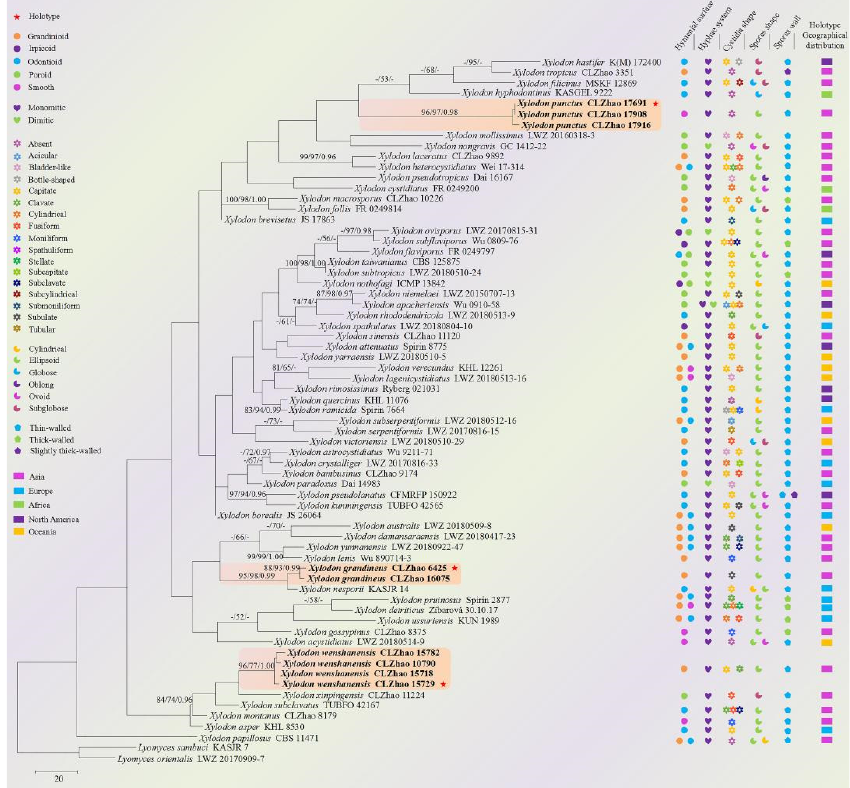
Figure 2. Maximum parsimony strict consensus tree illustrating the phylogeny of three new species in Xylodon based on ITS sequences. Branches are labeled with a maximum likelihood bootstrap value > 70%, a parsimony bootstrap value > 50%, and Bayesian posterior probabilities > 0.95, respectively. The new species are in bold. The red stars representative holotypes. Maximum parsimony (MP), maximum likelihood (ML), and Bayesian inference (BI) analyses were applied to the combined three datasets following a previous study [58], and the tree construction procedure was performed in PAUP* version 4.0b10 [59]. All of the characters were equally weighted, and gaps were treated as missing data. Using the heu- ristic search option with TBR branch swapping and 1000 random sequence additions, trees were inferred. Max trees were set to 5000, branches of zero length were collapsed, and all parsimonious trees were saved. Clade robustness was assessed using bootstrap (BT) analysis with 1000 replicates [60]. Descriptive tree statistics, tree length (TL), the con- sistency index (CI), the retention index (RI), the rescaled consistency index (RC), and the homoplasy index (HI) were calculated for each maximum parsimonious tree generated. The multiple sequence alignment was also analyzed using maximum likelihood (ML) in RAxML-HPC2 [61]. Branch support (BS) for ML analysis was determined by 1000 boot- strap replicates. MrModeltest 2.3 [62] was used to determine the best-fit evolution model for each dataset for Bayesian inference (BI), which was performed using MrBayes 3.2.7a with a GTR+I+G model of DNA substitution and a gamma distribution rate variation across sites [63]. A total of four Markov chains were run for two runs from random starting trees for 1.2 million generations for ITS+nLSU (Figure 1) and 9 million generations for ITS (Figure 2) with trees and parameters sampled every 1000 generations. The first one-fourth of all of the generations were discarded as burn-ins. The majority-rule consensus tree of all of the remaining trees was calculated. Branches were considered significantly supported if they received a maximum likelihood bootstrap value (BS) of >70%, a maximum parsimony bootstrap value (BT) of >70%, or Bayesian posterior probabilities (BPP) of >0.95.